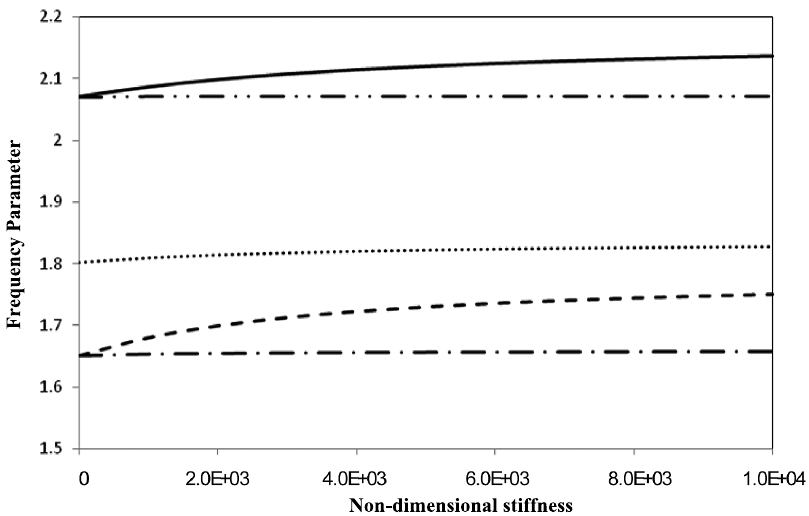
Fig. 4. Variation in the frequency parameters of selected modes with varying normalized point support stiffness at the outer edge of an annular disk free at the inner edge ( v = 0.3, β = 0.2)), (1,1)E, (1,1)O, (0,0)E, (0,3)E, (0,3)O.